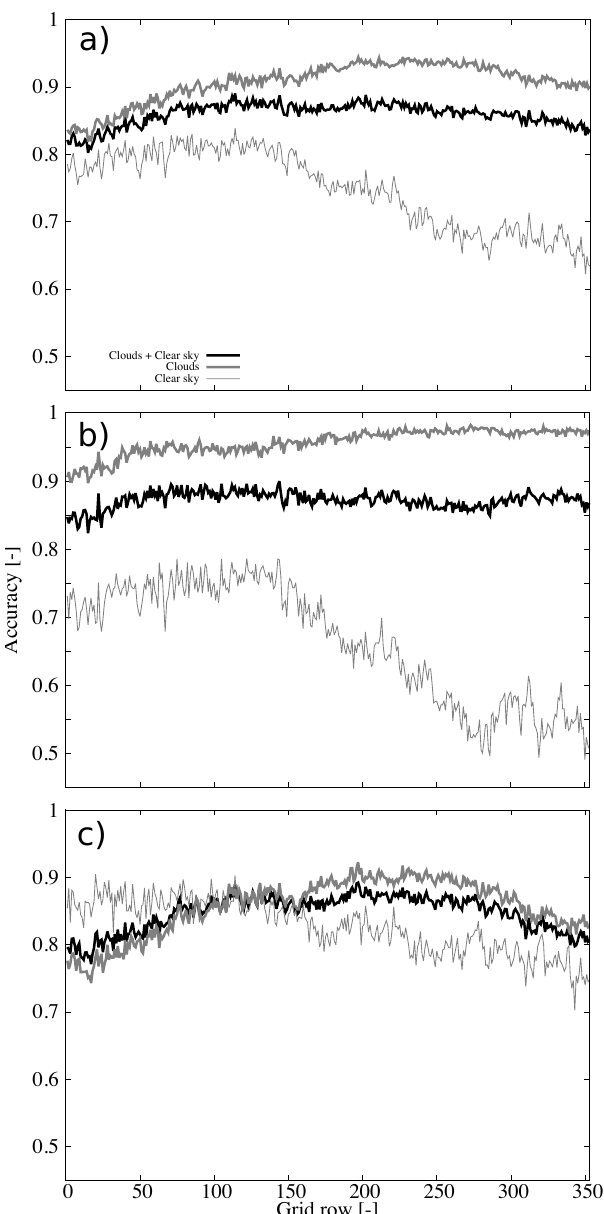
Figure 7. Accuracy as a function of the grid row for ( a ) all retrievals, ( b ) daytime retrievals, and ( c ) nighttime retrievals. The accuracy for all-sky conditions, cloud detection, and clear sky detection are shown (see